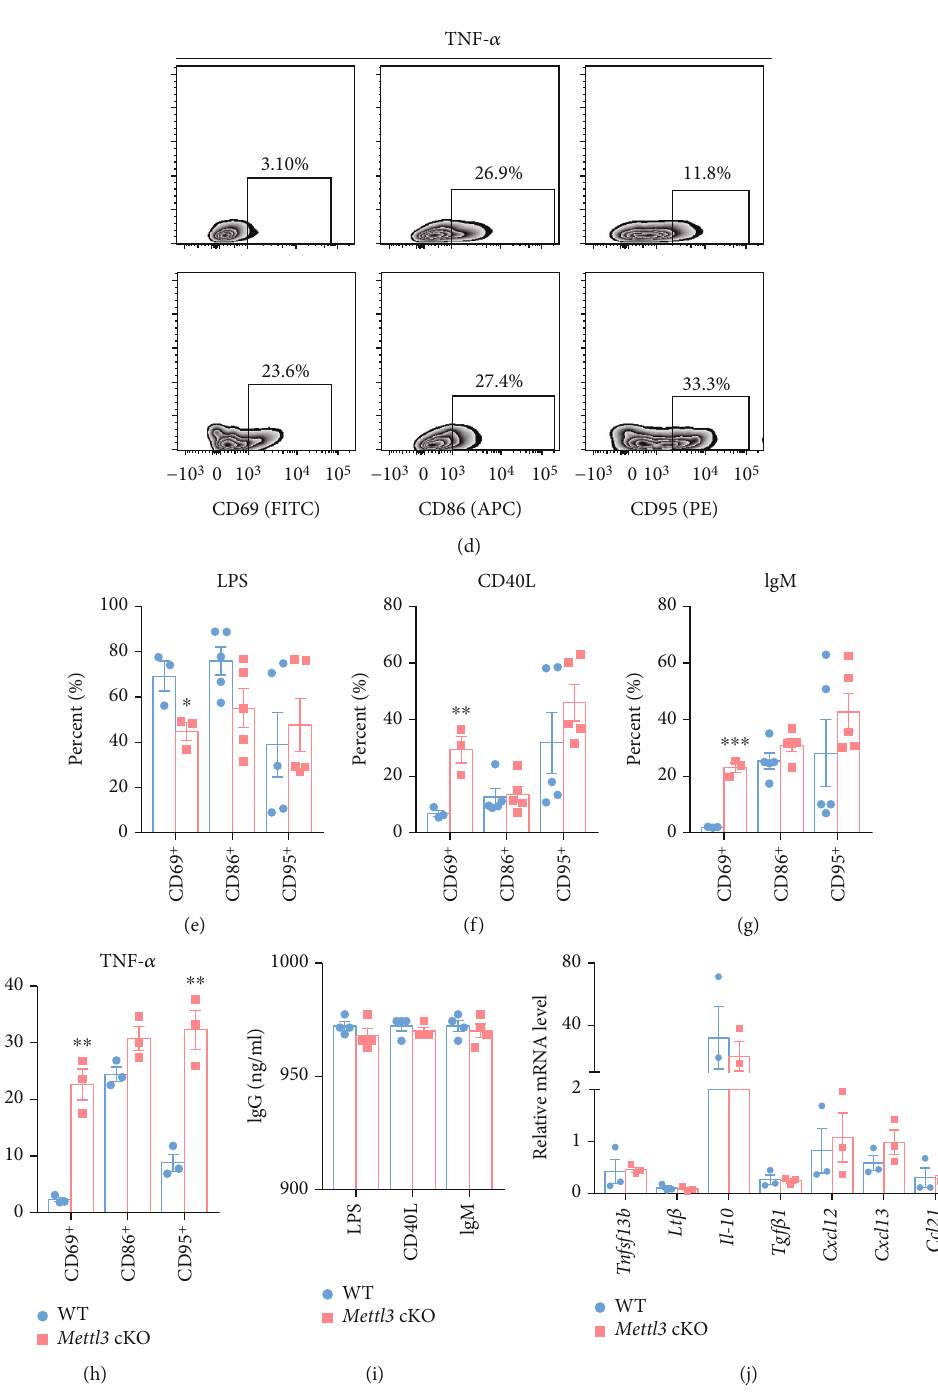
Figure 4: Knockout of Mettl3 minimally a ff ects B cell activation upon stimulation in vitro. B cells were isolated from the spleen of WT and Mettl3 cKO mice by using CD19 microbeads and treated with LPS (2 μ g/ml), CD40L (100ng/ml), anti-IgM (1 μ g/ml), or TNFa (50 ng/ml). Cells were cultured for 2 days, then collected and subjected to fl ow cytometry. (a) – (h) Representative fl ow cytometry plots (a) – (d) and quanti fi cation (e) – (h) of indicated populations in indicated groups. (i) ELISA assay for IgG secretion of B cells treated with LPS (2 μ g/ml), CD40L (100 ng/ml), and anti-IgM (1 μ g/ml) for 2 days. (j) RT-qPCR analysis for indicated genes in B cells of indicated groups upon LPS stimulation ( n = 3 /group). Data in (e) – (h) were presented as means ± SEM with the indicated signi fi cance ( ∗ P < 0 : 05 , ∗∗ P < 0 : 01 , ∗∗∗ P < 0 : 001 ; student ’ s t